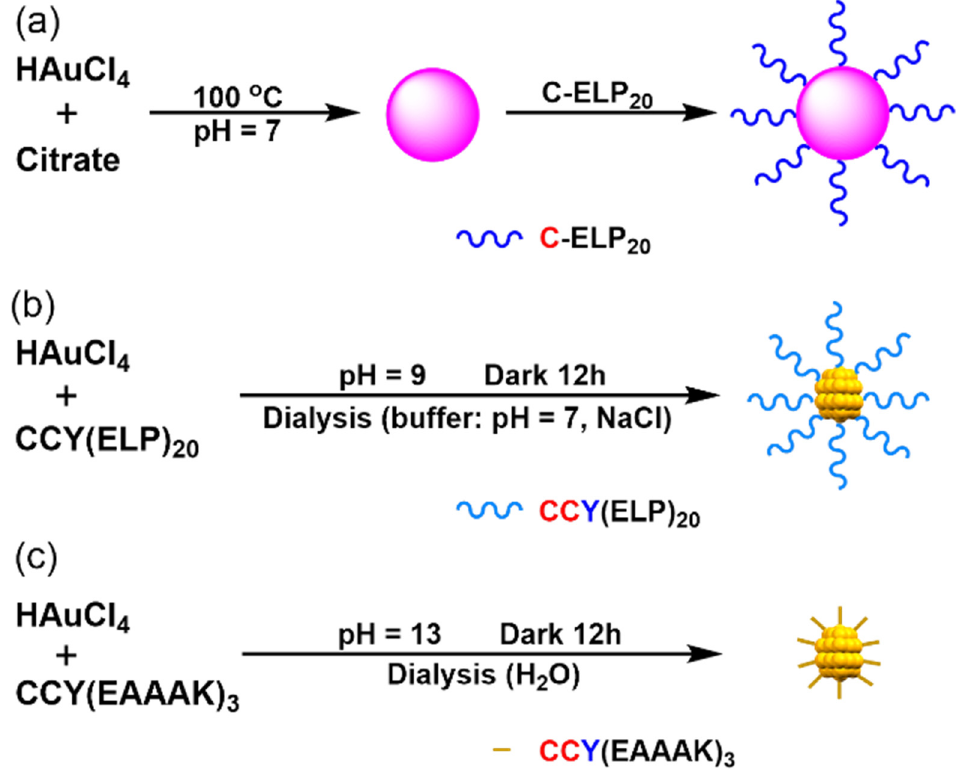
Figure 1. Schematic illustration of the synthesis of ( a ) (ELP) 20 -Au NSs. ( b ) (ELP) 20 -Au NCs. ( c ) (EAAAK) 3 -Au NCs.